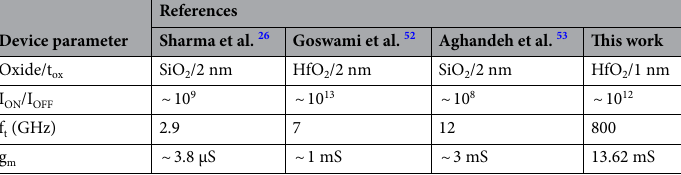
Table 3. Performance comparison of proposed device with the state-of-the-art DG-JLTFETs.